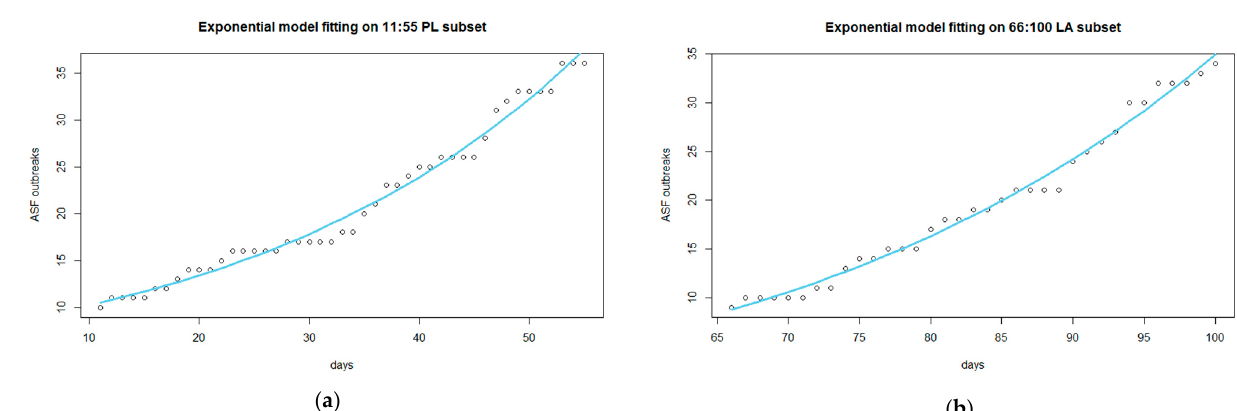
Figure 5. Model fitting for the selected subset 11:55 for Piedmont-Liguria infected area ( a ) and for 66:100 subset selected for Lazio infected area ( b ). Table 2. Estimated exponential model parameters.